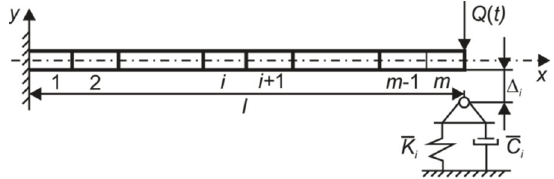
Figure 14. Scheme of the developed 2-D finite element model of the impacting